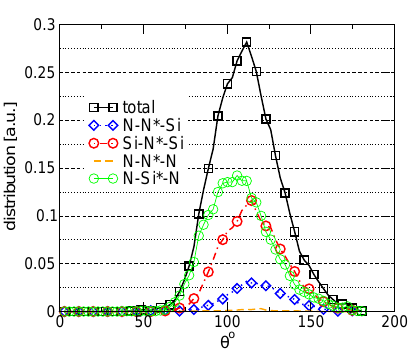
Fig. 5. Calculated angular distribution for the liquid Si 3 N 4